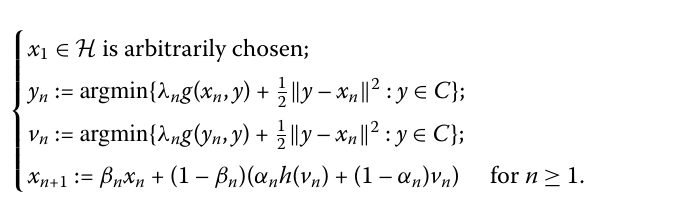
Algorithm 1 Let { x n } ⊂ H be a sequence defined